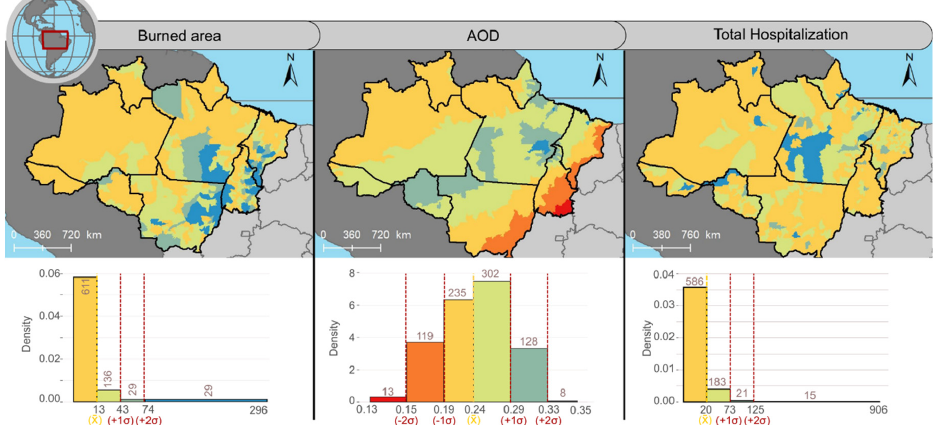
Figure 2. Spatialization of the time-series average for burned area, AOD, and total hospitalizations, aggregated by municipalities The bar plot represents the histogram of the spatialized variable, the bar shows the number of municipalities in each class, and the vertical lines exhibit the mean (yellow) and the first and second deviations